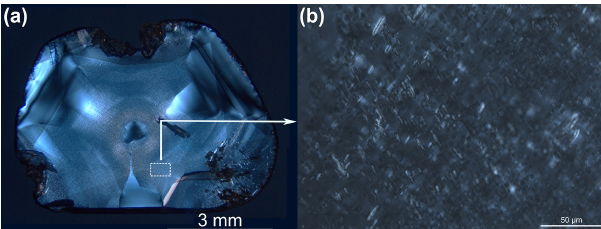
Figure 3. Birefringence in NDS-2 under cross-polarized light (mod- ified after Sun et al., 2022). (a) Sharp straight birefringence patterns in octahedral sectors. (b) Birefringence caused by dense directional micro-cracks in cuboid